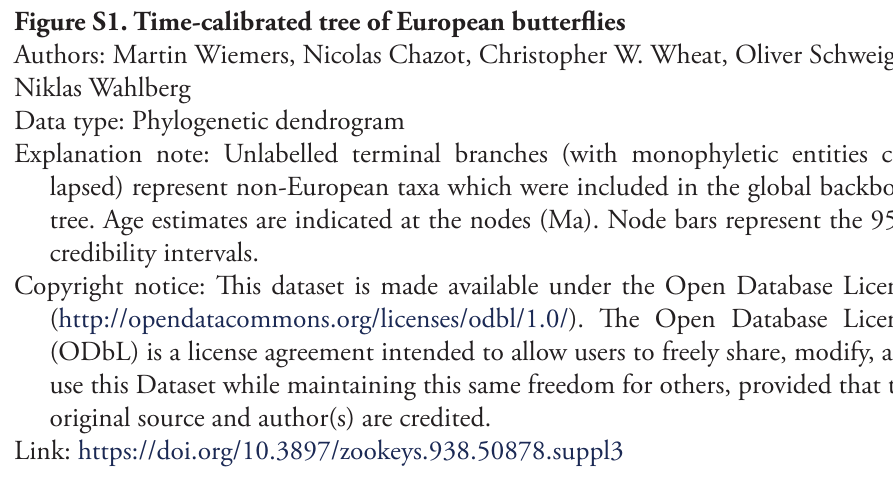
Figure S1. Time-calibrated tree of European butterflies